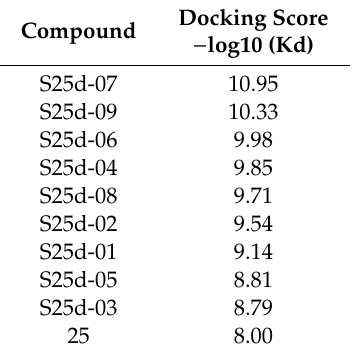
Table 2. HDAC4 docking scores of cyclopropane derivatives having aliphatic moieties in the lower selectivity